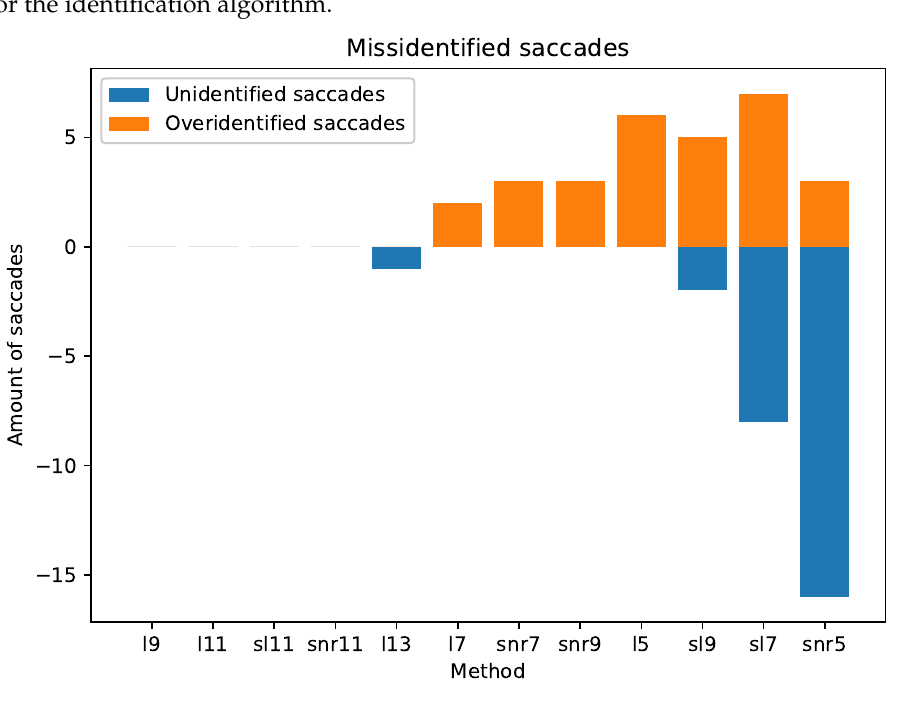
Figure 4. Number of misidentified saccades by the different methods.